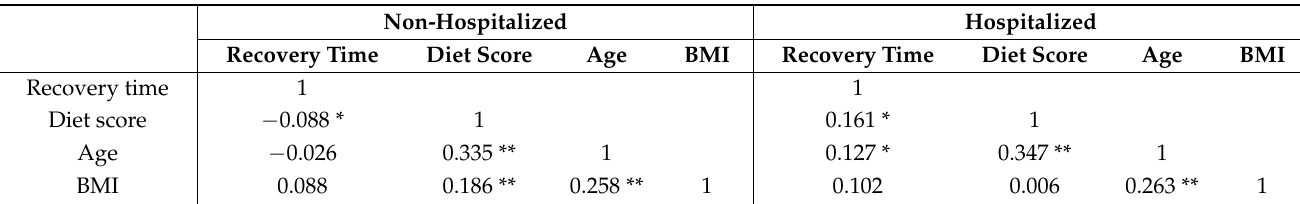
Table 4. Correlation matrix of healthy diet score, recovery time (days), age, and BMI for hospitalized and non-hospitalized respondents.